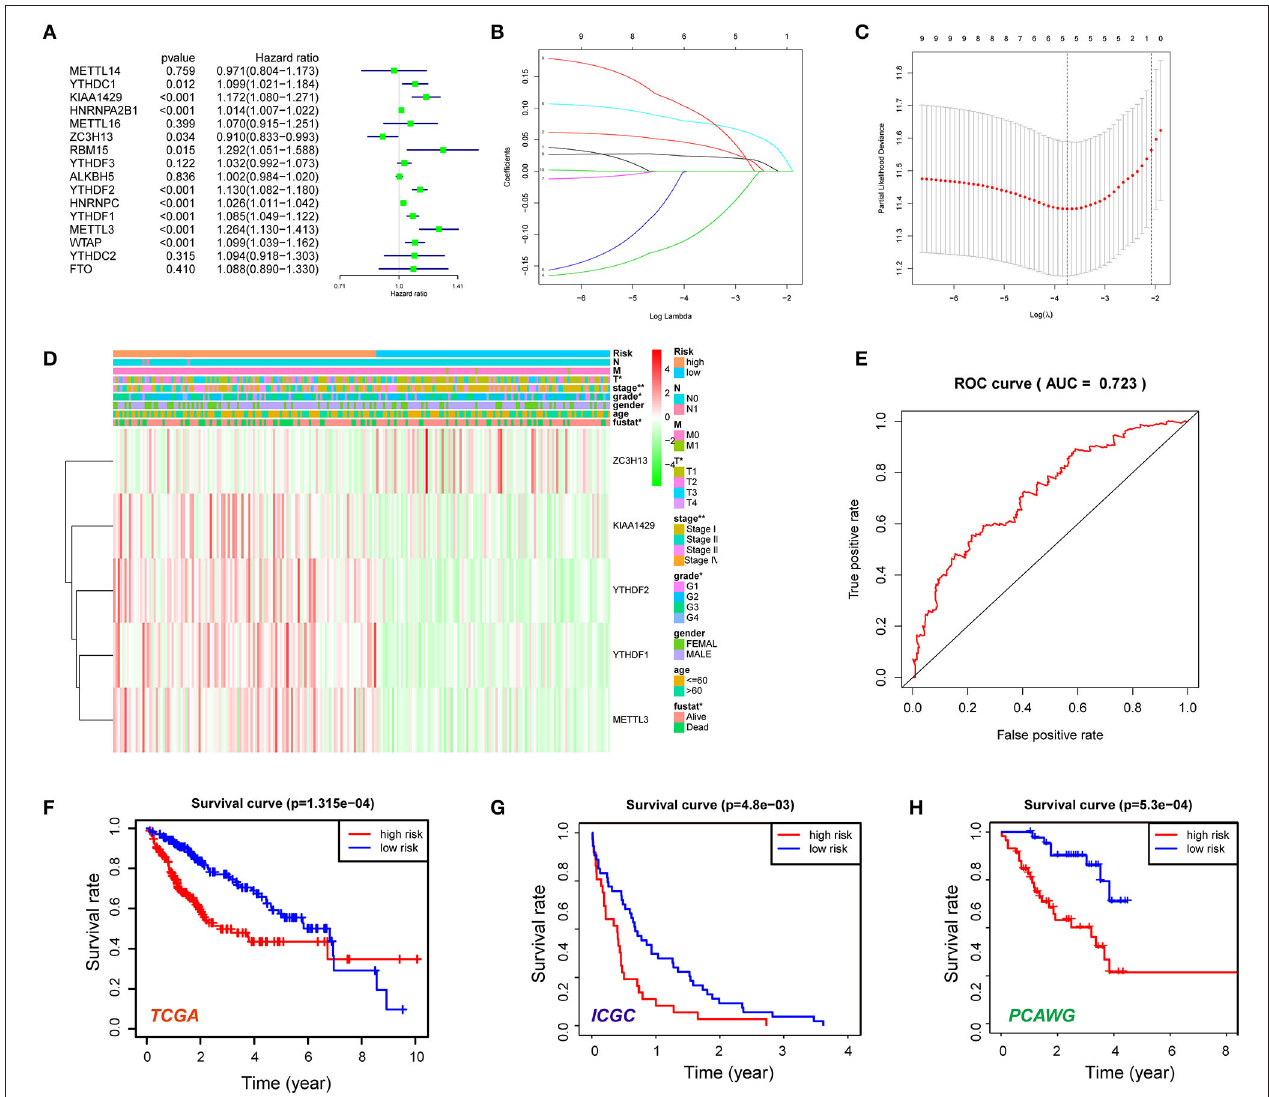
FIGURE 3 | Construction of the five N6-methyladenosine (m 6 A) RNA methylation regulator-based risk signature. (A) Univariate Cox regression was performed to screen the signature in 16 m 6 A RNA methylation regulators. (B,C) The coefficients of the five-gene signature (KIAA1429, ZC3H13, YTHDF1, YTHDF2, and METTL3) calculated by multivariate Cox regression with least absolute shrinkage and selection operator (LASSO). (D) The expression features of the five m 6 A RNA methylation regulators and the distribution of clinicopathological features were compared between the low- and high-risk groups of The Cancer Genome Atlas (TCGA) liver hepatocellular carcinoma (LIHC) datasets. (E) Receiver operating characteristic (ROC) curves were calculated to evaluate the predictive efficiency of the five-gene risk signature. (F) The Kaplan–Meier curves of HCC patients at the high-risk group and low-risk group in TCGA cohort. (G) The Kaplan–Meier curves of HCC patients